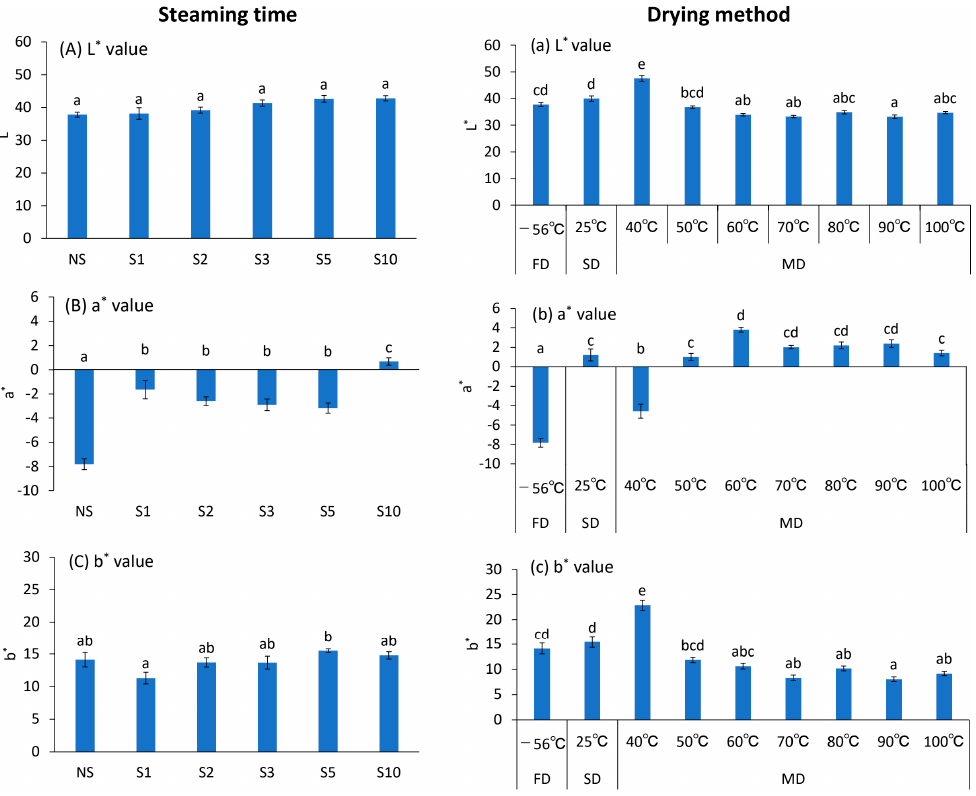
Figure 3. E ff ects of di ff erent treatment conditions on the color of Ocimum basilicum cv. ‘Genovese’ tea. ( A, a ) L* values, ( B, b ) a* values, and ( C, c ) b* values. FD: Freeze-drying (–56 °C, 48 h), NS: